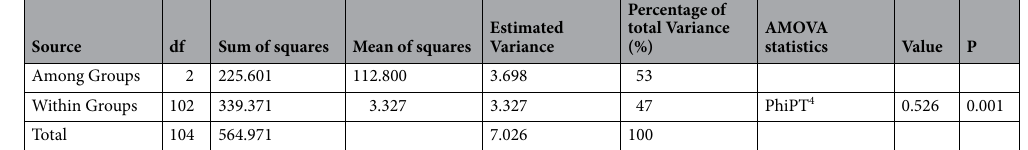
Table 4. AMOVA results of 105 sweet potato germplasms with the K = 3 model.